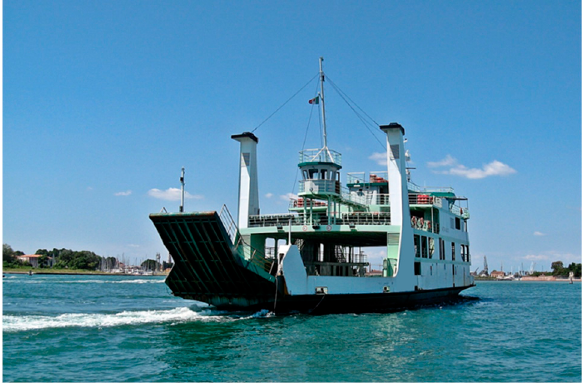
Figure 1. A typical RO-Pax small size ferry. Table 2. The main characteristics of the RO-Pax ferry proposed as a case study. Power system vol- ume and weight have been elaborated from data available on diesel storage on board and a diesel- electric generator for marine propulsion, scaled by the installed power of the ferry.